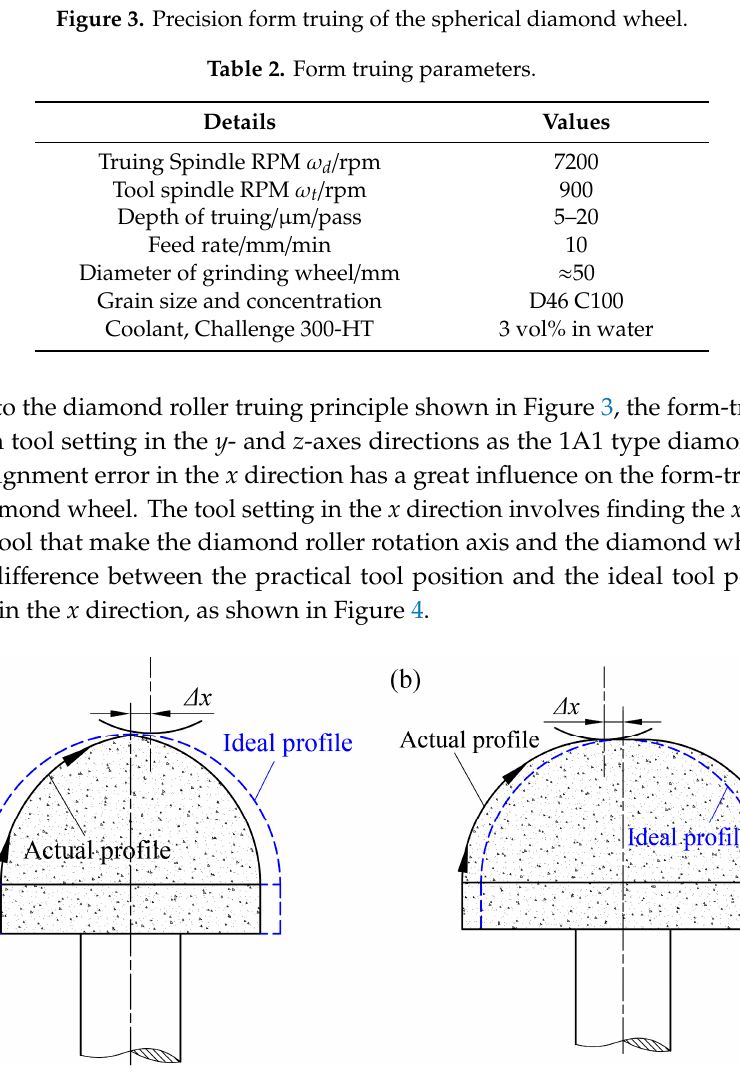
Figure 4. Influence of the alignment error on the profile of the spherical diamond wheel: ( a ) diamond roller not to center, ( b ) diamond roller past center.